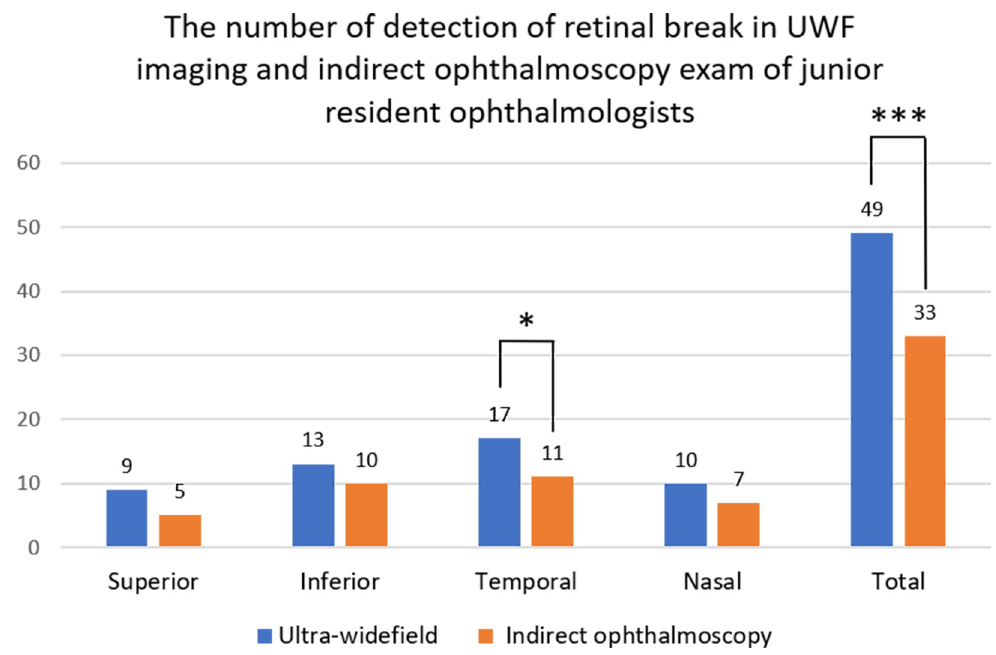
Fig 3. Number of retinal breaks detected by indirect ophthalmoscopy and UWF imaging examinations by junior resident ophthalmologists. For the indirect ophthalmoscopy examination, a total of 33 retinal breaks were detected in the 31 eyes. There were 5, 10, 11, and 7 retinal breaks detected in the superior, inferior, temporal, and nasal quadrants, respectively. For the UWF imaging, a total of 49 retinal breaks were detected in the 31 eyes, and there were 9, 13, 17, and 10 retinal breaks detected in the superior, inferior, temporal, and nasal quadrants, respectively. � P < .05, �� P < .01, ��� P < .001, Fisher’s exact test.